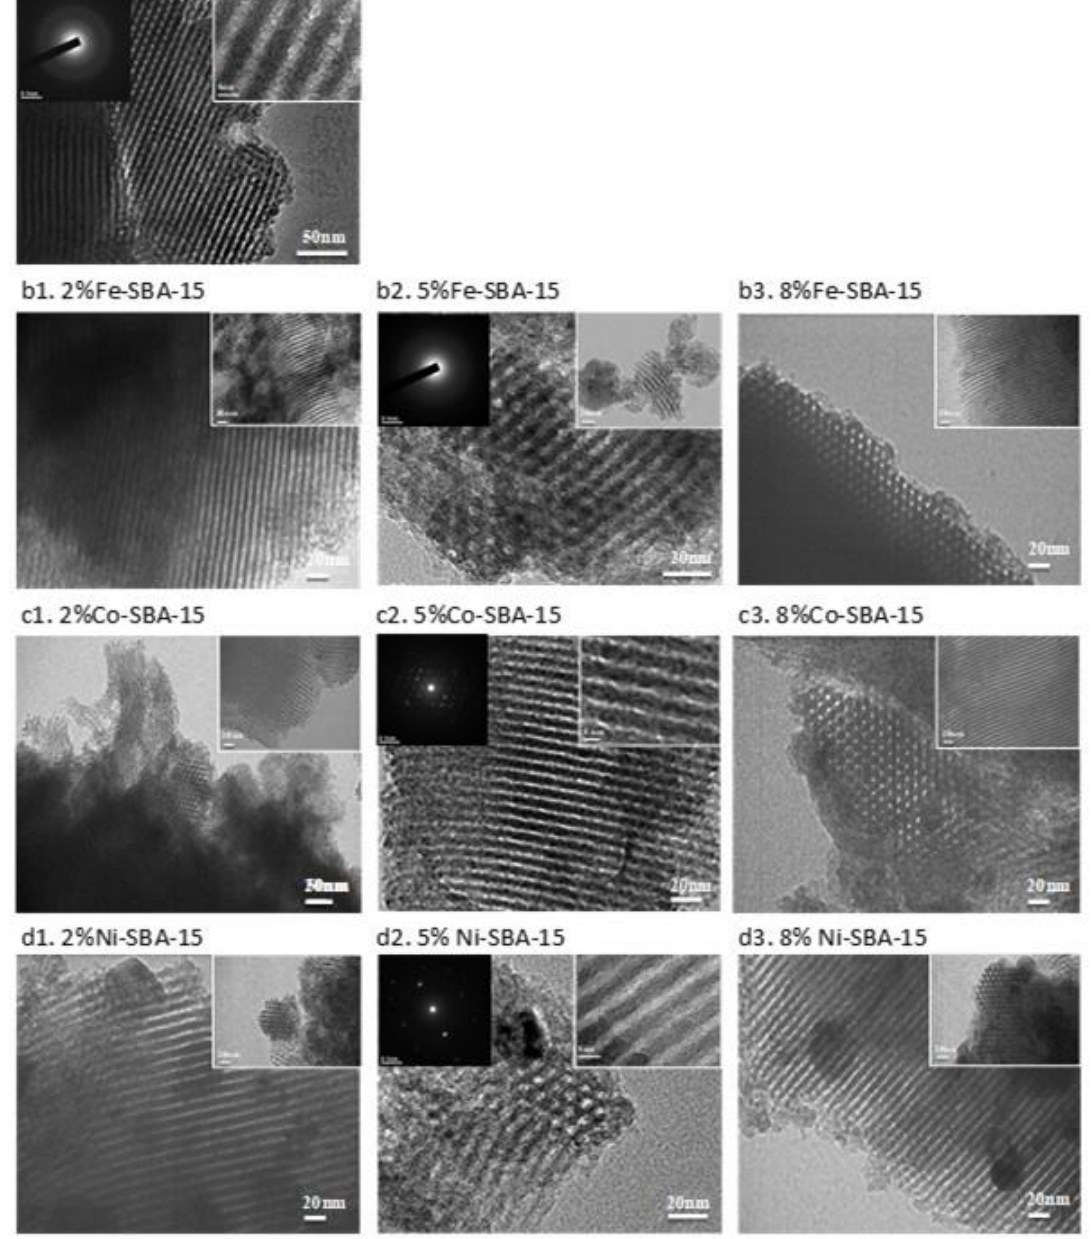
Figure 2. TEM morphology of SBA-15 and Fe-, Co-, and Ni-impregnated (2 – 8wt%) SBA-15.